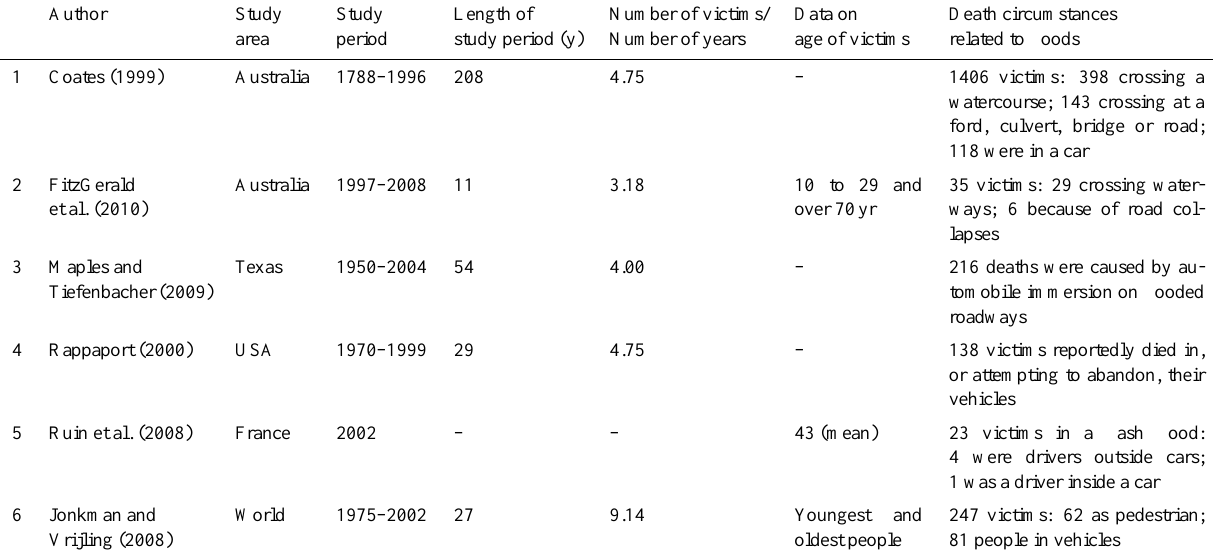
Table 1. Summary table of papers reported in references and describing floods damage to